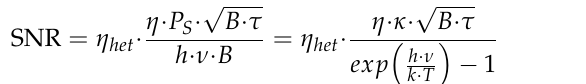
where the overall optical coupling efficiency κ is defined as the fraction of the incoming signal radiation transmitted through all the optical components to the photomixer [25]. For the BB, this accounts for two CaF 2 lenses (transmission ~0.92 each), the PIR fiber (transmission ~0.54), the Germanium lens (transmission ~0.99), the BS (transmission ~0.95), the silver-plated OAPM (assumed reflectance ~0.97), and the BaF 2 wedged window in front of the photomixer (transmission ~0.95), resulting in an overall coupling efficiency of 0.396. The heterodyne efficiency η het of the photomixing of the sunlight beam and the LO beam is considered to be 1 in an ideal case [26]; the quantum efficiency η of the photomixer provided by the manufacturer at this wavelength is 0.5. Under these conditions, given an LHR double-side bandwidth of 485 MHz (for an RF pass-band of 27.5–270 MHz) and a 1 s time constant of the LIA at an LO frequency (1242.3 cm − 1 or 3.73 × 1013 Hz), a shot-noise-limited SNR of about 1430 was obtained. The theoretical shot-noise-limited SNR is 3.4 times higher than the measured SNR at a photocurrent of 610 µ A, or a factor ρ of 0.29 in the theoretical SNR was